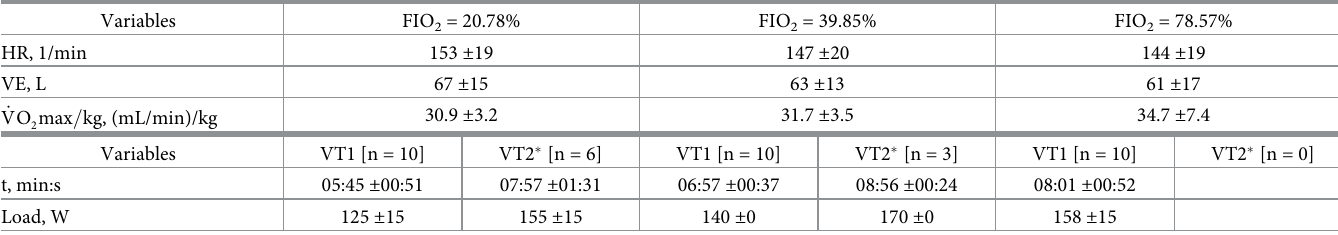
� was not achieved by any of the participants within the test protocol. Abbreviations: HR heart rate, VE ventilation, _ VO ventilatory threshold, FIO 2 inspiratory oxygen